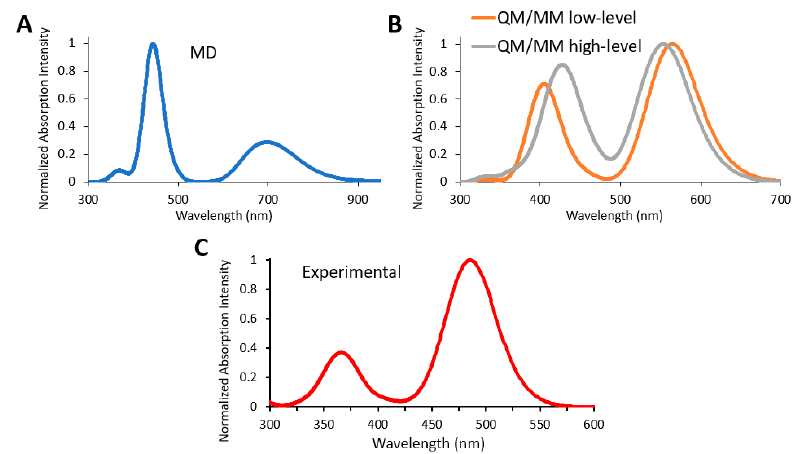
Figure 10. Simulated absorption spectra taking the snapshots from ( A ) the classical MD simulation and ( B ) the QM/MM simulations both at the low and high levels of theory. ( C ) Experimental absorption spectrum of oxyluciferin.